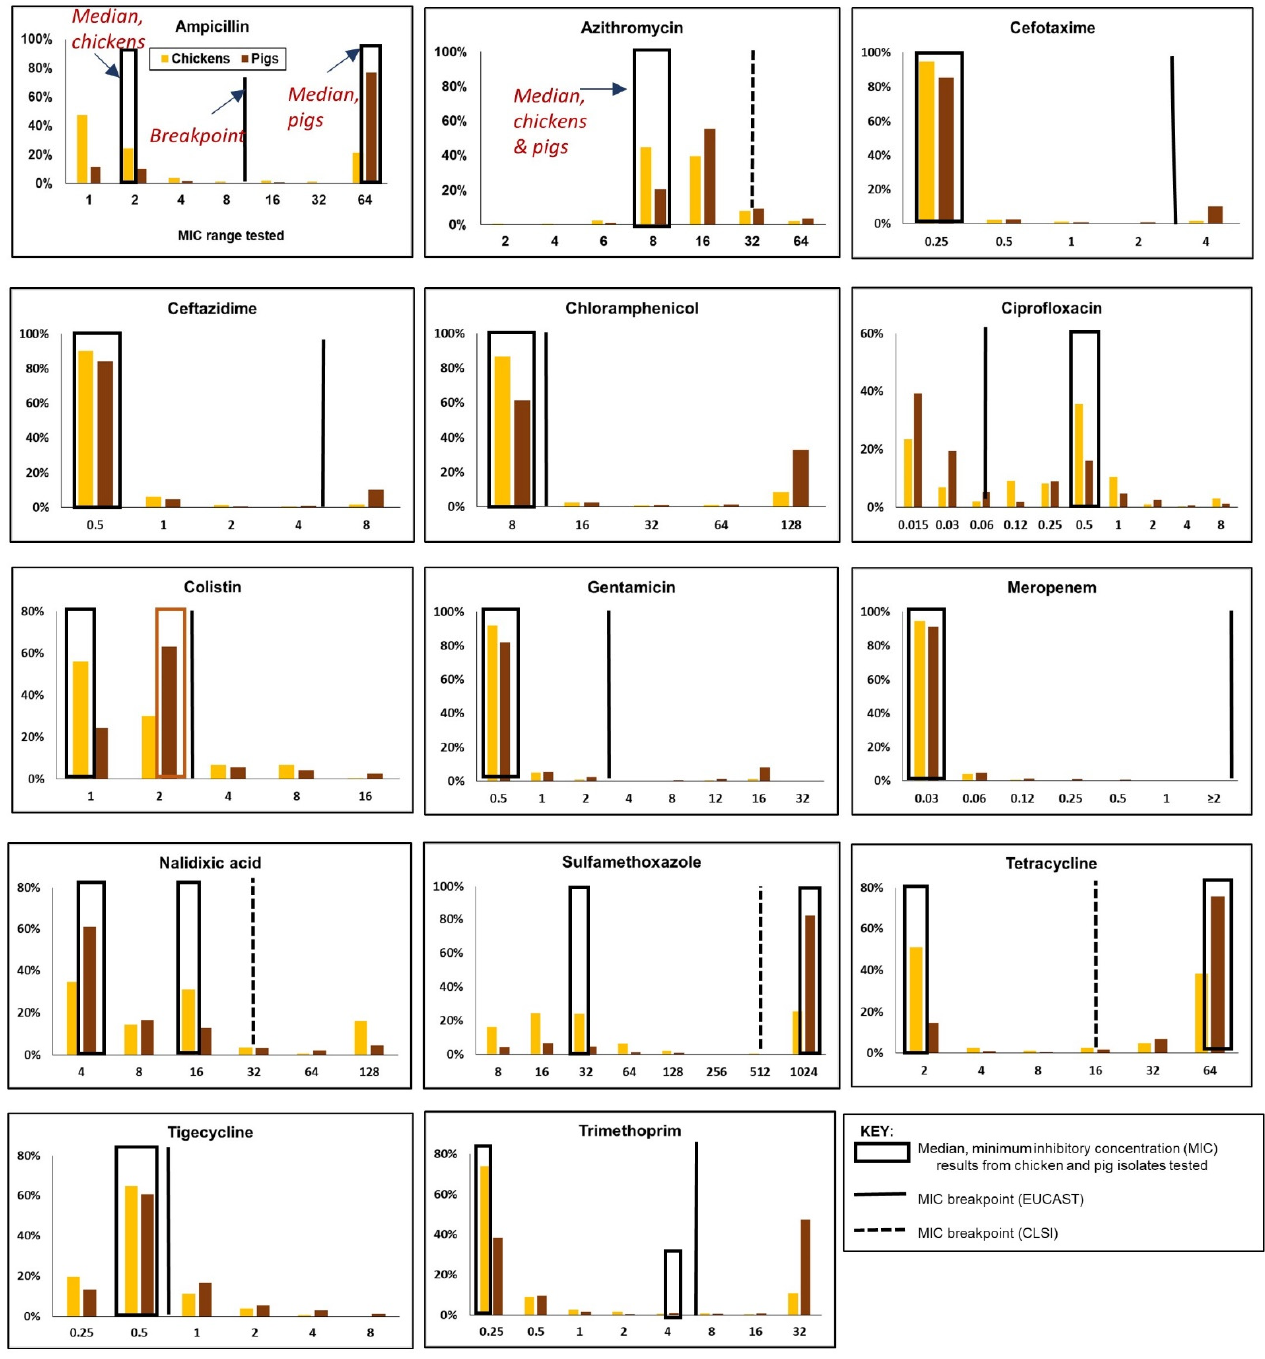
Figure 5. Distribution of minimum inhibitory concentrations (MICs) in a panel of 14 antimicrobials, showing the relative locations of the clinical breakpoints and the median MIC values in Salmonella spp. isolated from chickens ( n = 698 isolates) and pigs ( n = 673).